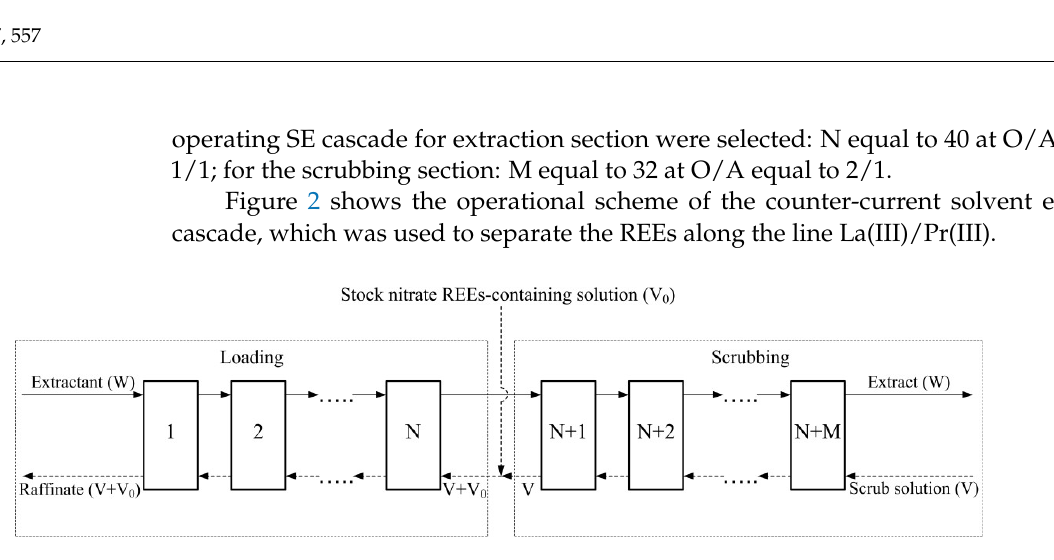
Figure 2. Counter-current extraction cascade operational scheme for separation of REEs to the line La(III)/Pr(III) in nitrate solution containing 258 g La(III)/L, 58 g Pr(III)/L, 141 g Nd(III)/L, and 0.1 mol/L HNO 3 using 0.6 mol/L TOMANO 3 -2.4 mol/L TBP mixture in dodecane. N—18; M—14; O/A (loading)—2/1; O/A (scrubbing)—2.8/1; W—organic phase flow; V—scrub solution flow; V + V 0 — REE-containing nitrate solution and scrub solution total flow.